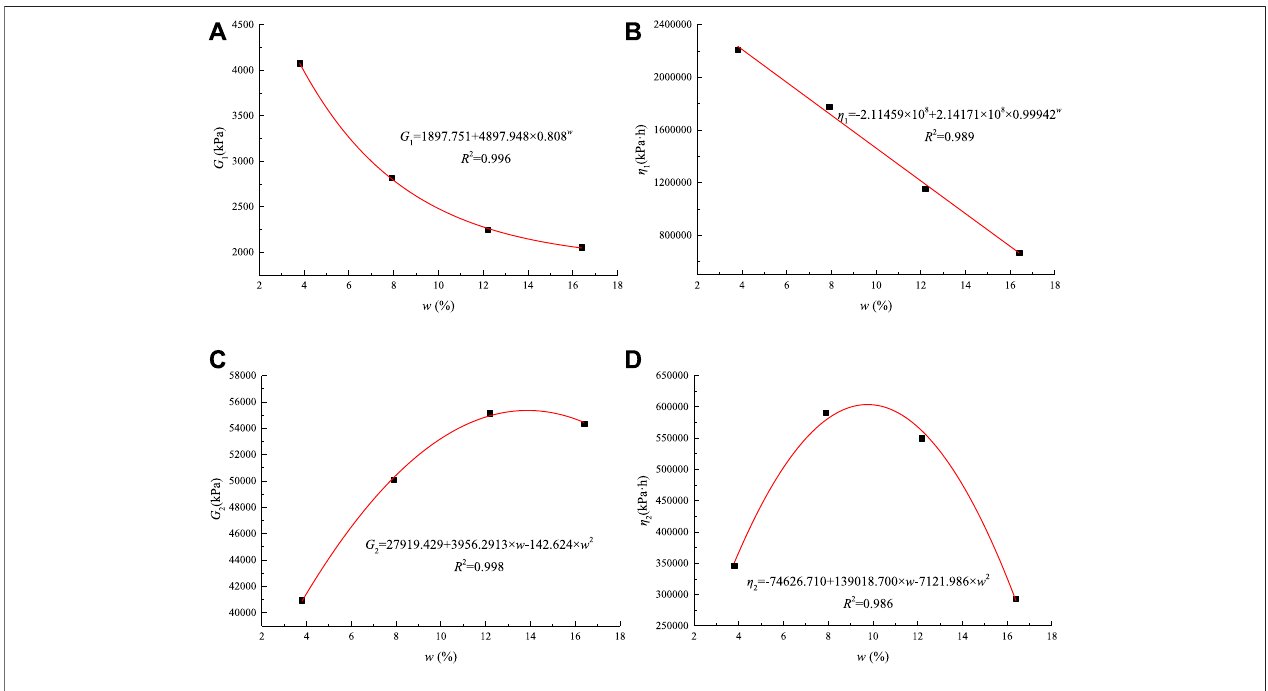
FIGURE 4 | Correlation between model parameters and water content.